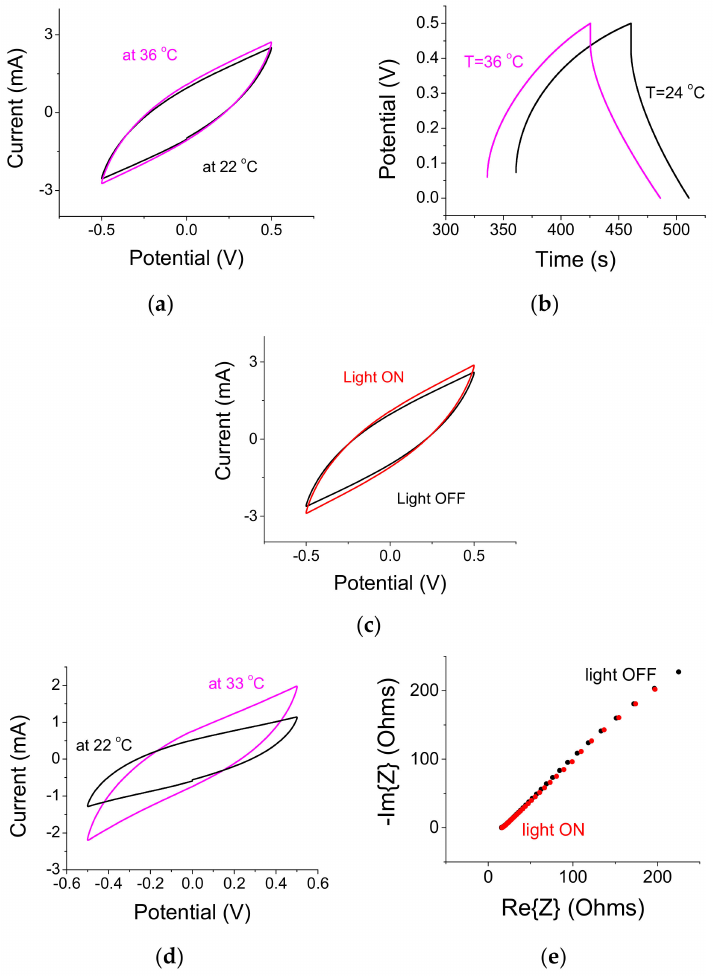
Figure 6. ( a ) The sample was heated when the light was OFF from 22 to 36 ◦ C. CV curves were obtained at a scan of 0.1 V/s. ( b ) CD curves when a sample was measured at two stabilized temperatures. ( c ) CV curves for light OFF (room lighting) and light ON. ( d ) CV for A-C electrode embedded with CdSe/ZnS quantum dots. The relative capacitance change due to the thermal effect is ~35%. ( e ) EIS for A-C embedded with CdSe/ZnS quantum dots; the trend of the curve points to highly resistive samples at low